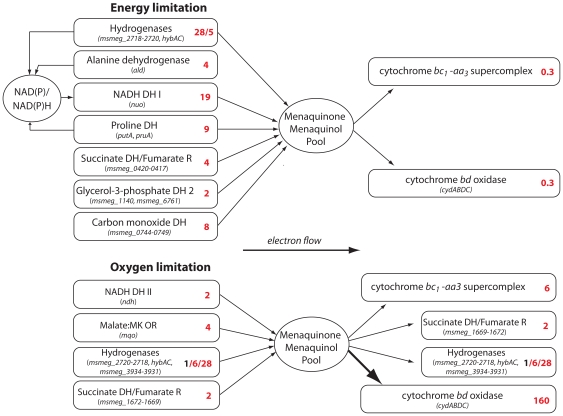
Proposed scheme of enzymes preferentially used in the respiratory chain of M. smegmatis under energy- and oxygen-limiting conditions.Data shown is based on gene expression ratios (indicated as red numbers next to gene name). See Table 2, Table S1 and Dataset S1 for detailed expression data.